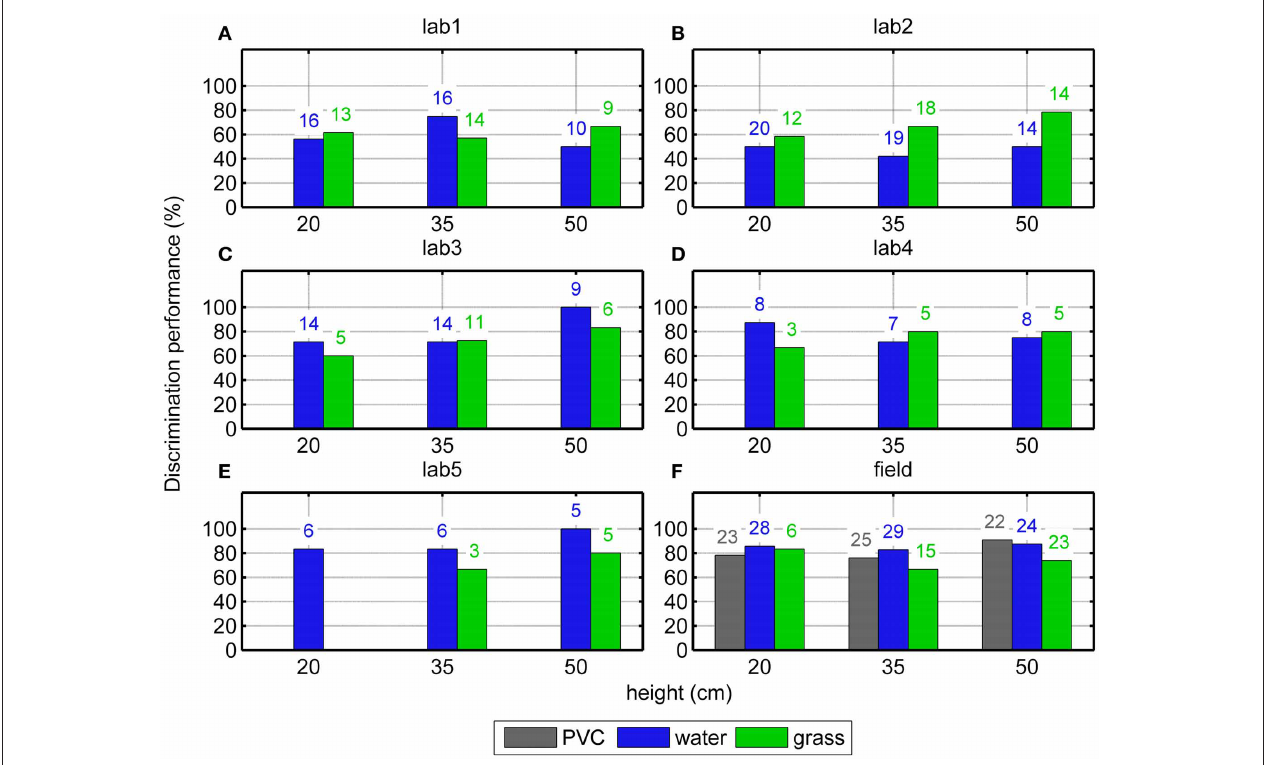
FIGURE 3 | Discrimination performance above different surfaces at differentheights. Resultsfrom5batsinthelaboratory(“lab1-5”, A–E )andfrom the field (“field”, F ) are shown. There is a statistically significant decrease of